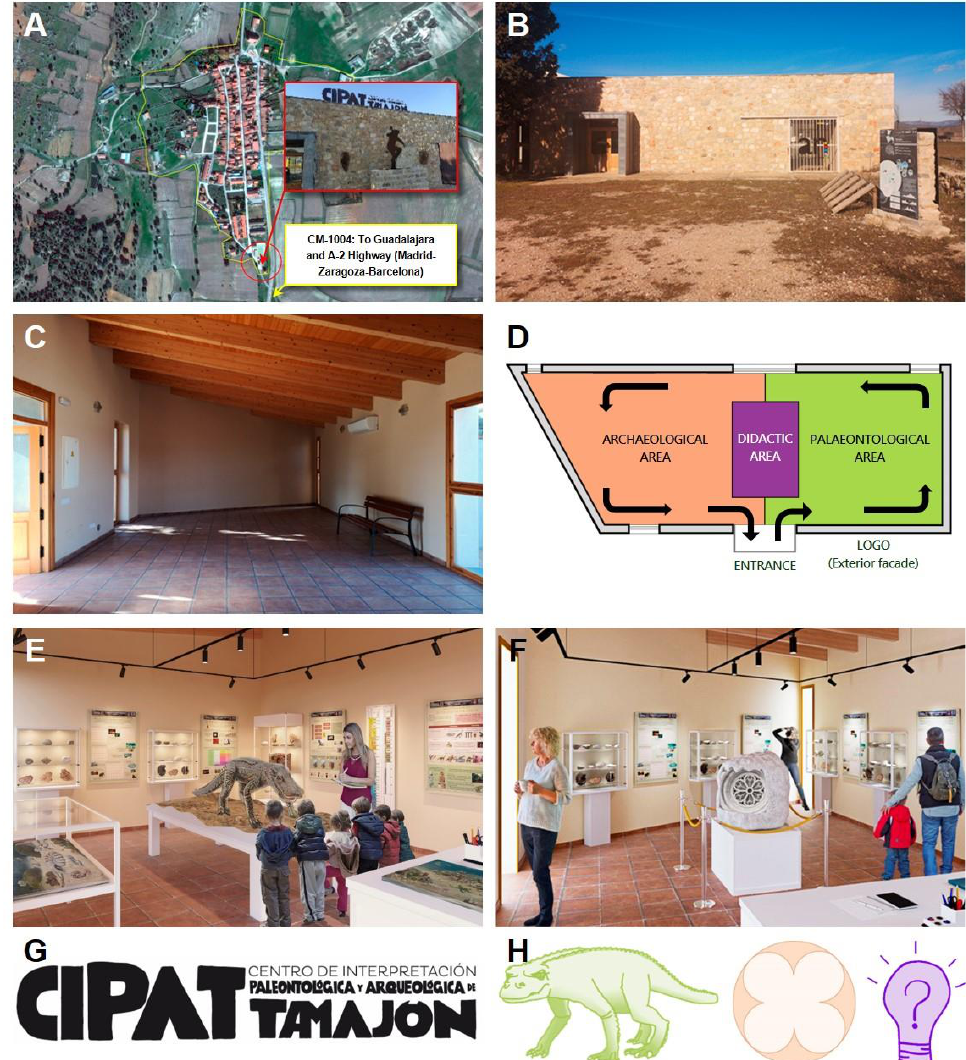
Figure 4. ( A ) Location of the former tourist information building of the cultural centre of Tamajón (Guadalajara, Spain), currently housing the Paleontological and Archaeological Interpretation Centre of the locality (CIPAT), next to the access by the CM-1004 road to Guadalajara and the A-2 Highway (Madrid-Zaragoza-Barcelona; ( B ) Image of the original appearance (before development of this project) of the access area to the main facade of the former tourist information building of Tamajón; ( C ) Image of the original appearance of the interior of the former tourist information building of Tamajón; ( D ) Division of spaces proposed for the CIPAT, differentiating the Paleontological, Archaeological and Didactic areas and showing the itinerary designed for the visit; ( E , F ) Three-dimensional (3D) virtual models of a visit to the Paleontological ( E ) and Archaeological ( F ) areas of the CIPAT, showing the main central pieces, display cases with original samples and other materials, explanatory panels and dioramas; ( G ) Logo of the CIPAT, black and white version; ( H ) Motifs referring to the Paleontological (left), Archaeological (centre) and Didactic (right) areas of the CIPAT.